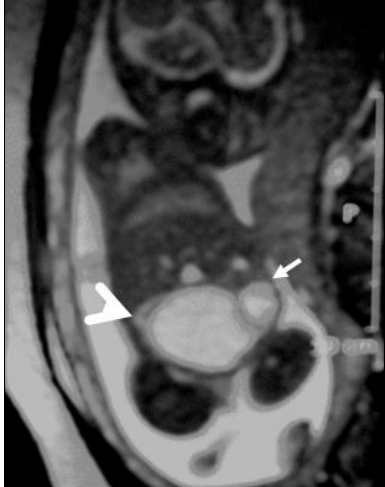
Figure 3: Fetal MRI showing type IV teratoma (big arrow head) and the white arrow demon- strates hydrometrocolpos.